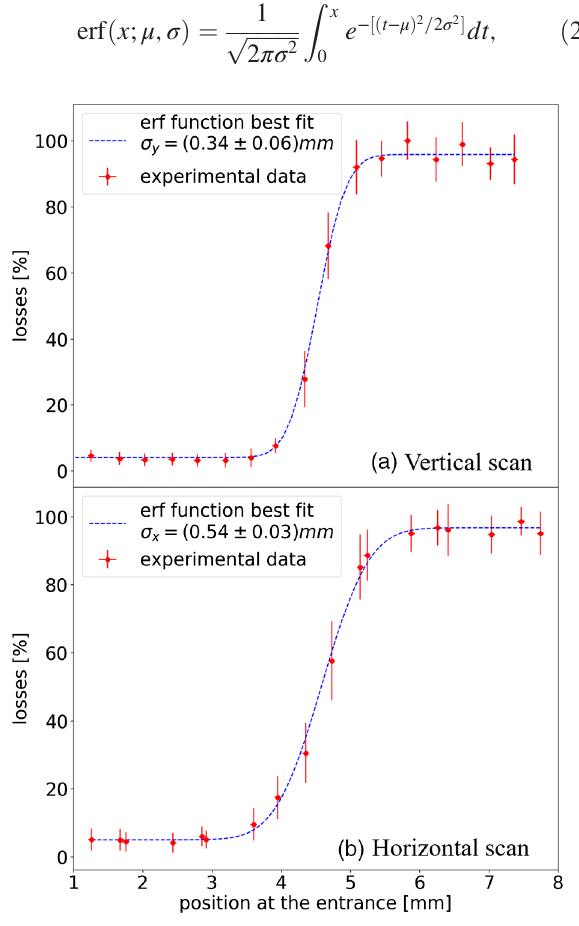
FIG. 3. Loss signals (red dots) measured as a function of the vertical (a) and horizontal (b) position at the vapor source entrance [calculated with Eq. (1)]. Every point is the mean value of 30 measurements; error bars are the standard deviation of the distribution for each point. Each plot is fitted with an error function according to Eq. (2) (blue dashed lines). For these measurements, the 200 pC electron beam is focused at the vapor source entrance (measurement